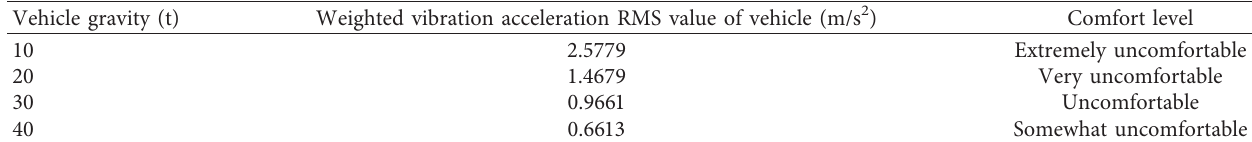
Table 4: The effects of vehicle gravity on the vehicle ride